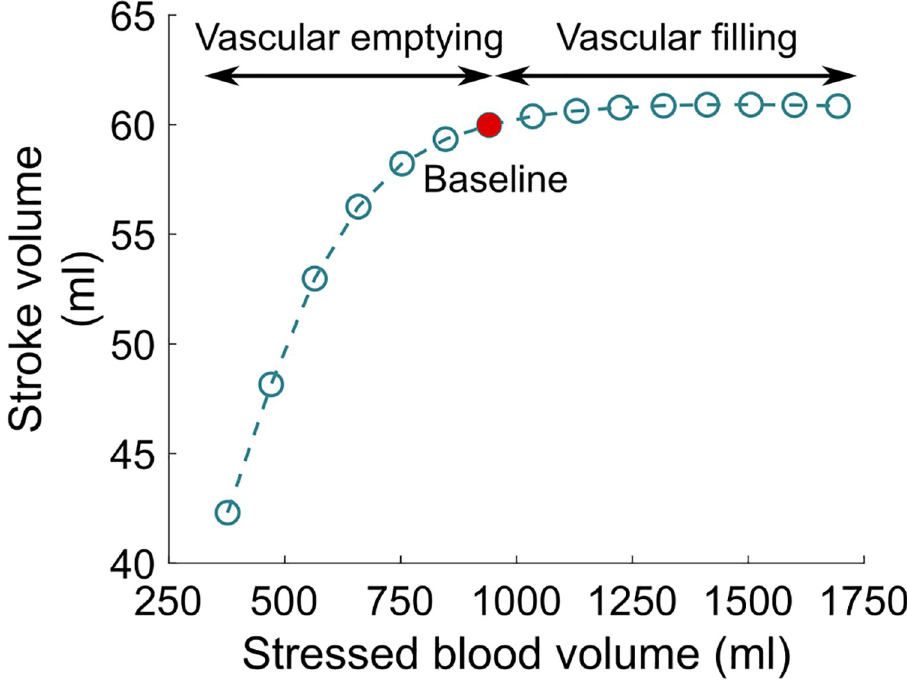
Fig 10. Vascular filling simulations. Stroke volume increases with filling, up to a saturating plateau. The red filled circle corresponds to the BL case (normal hemodynamics conditions).